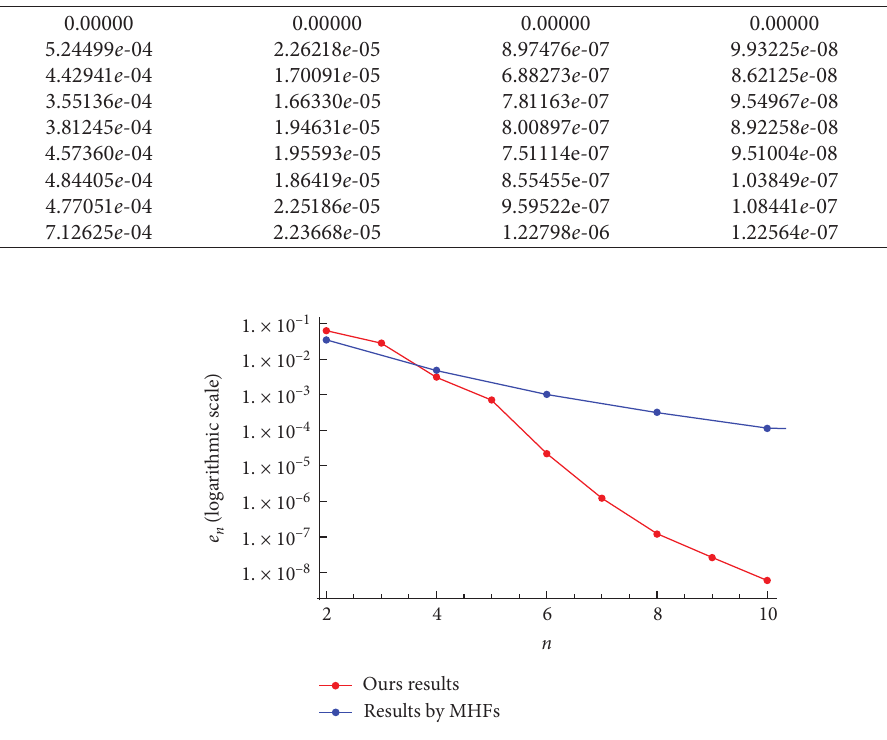
Figure 2: e n on logarithmic scale for different methods (Example